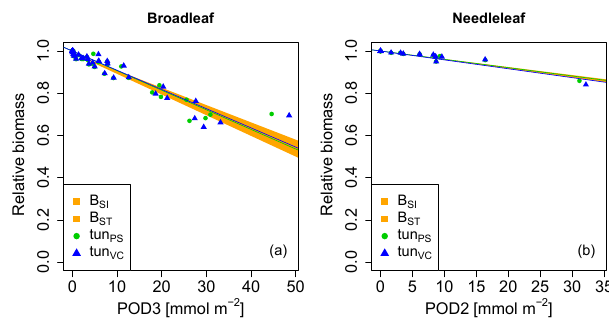
Figure 3. Biomass dose–response relationships for simulations based on tuned injury functions (see Table 1 for abbreviations), sep- arate for (a) broadleaved species and (b) needleleaf species. The dose–response relationships by Büker et al. (2015) ( B SI and B ST ) define the target area (orange). See Tables A5 and A6 for slopes, intercepts, R 2 and p values of the displayed regression lines. Injury calculation in the simulations is based on CUO1 (see Table 1) and not on POD2 or POD3 (see Sect. 2.5 for more details). Table 2. Slopes and intercepts of biomass (RB) and NPP (RN) dose–response relationships (DRRs) for broadleaved species sim- ulated by the tun VC model version (see Table 1). The fumigation of (cid:16) (cid:17) young trees tun young with O 3 is compared to the fumigation of VC (cid:1) mature trees (cid:0) tun mature VC